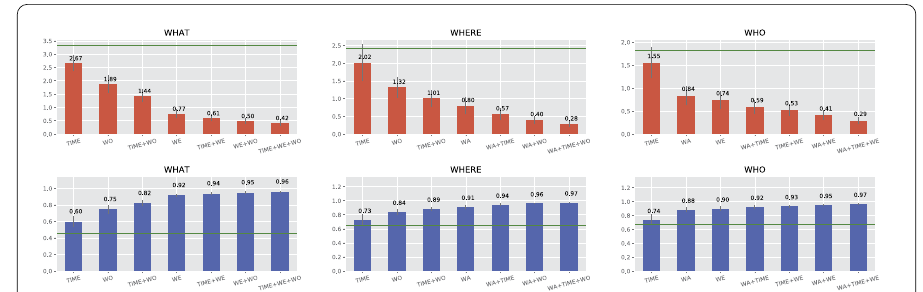
Figure 6 Entropy (top) and predictability (bottom) of each modality after conditioning on all subsets of other dimensions, averaged over all study participants. Left to right: the target modality is WA, WE, and WO, respectively. As more information about other dimensions is revealed, entropy decreases and predictability